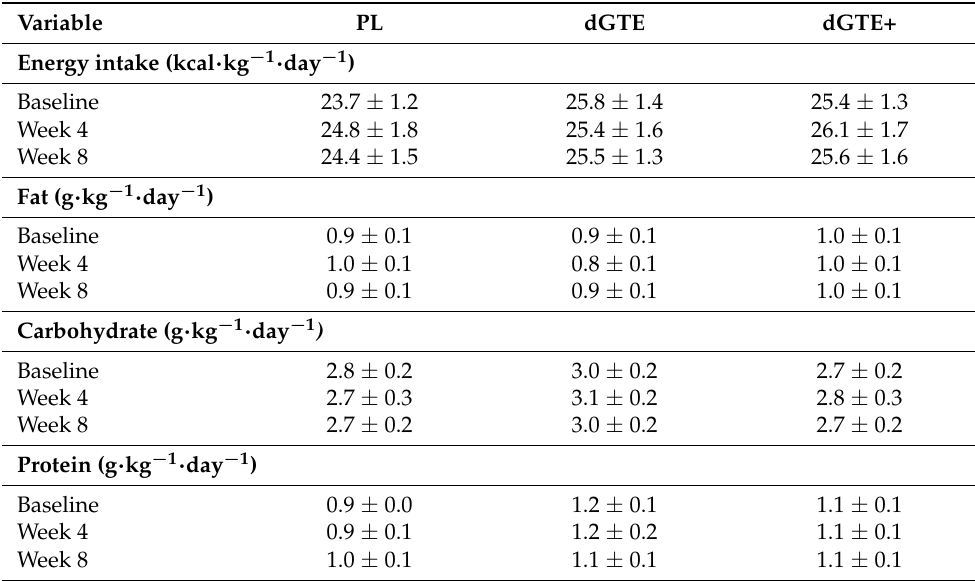
Table 2. Mean relative energy and macronutrient intake comparisons between